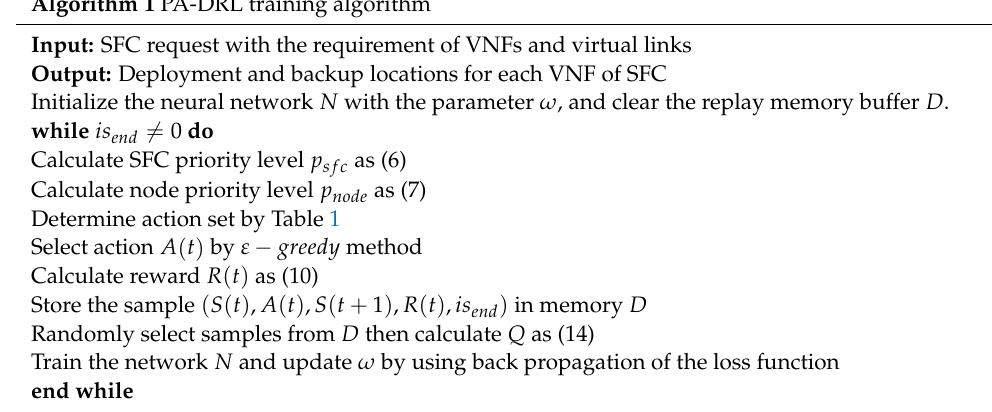
Algorithm 1 PA-DRL training